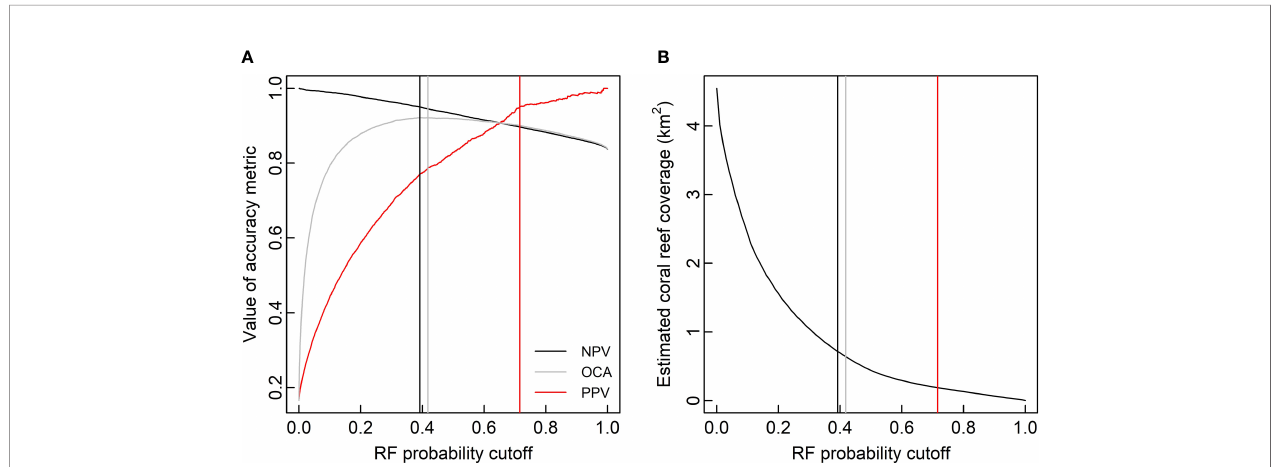
FIGURE 7 | Cold-water coral (CWC) reef coverage along the Tautra Ridge estimated by the random forest (RF) prediction model at different probability cutoffs. Panel (A) shows the RF prediction model ’ s validation set negative predictive value (NPV), overall classi fi cation accuracy (OCA) and positive predictive value (PPV) plotted as functions of probability cutoff. The black, gray and red vertical lines respectively correspond to probability cutoffs where NPV = 0.95, OCA is maximized (0.92) and PPV = 0.95. Panel (B) shows estimated CWC reef coverage along the Tautra Ridge plotted as a function of RF probability cutoff. The vertical lines correspond to the three cutoffs de fi ned in panel (A)